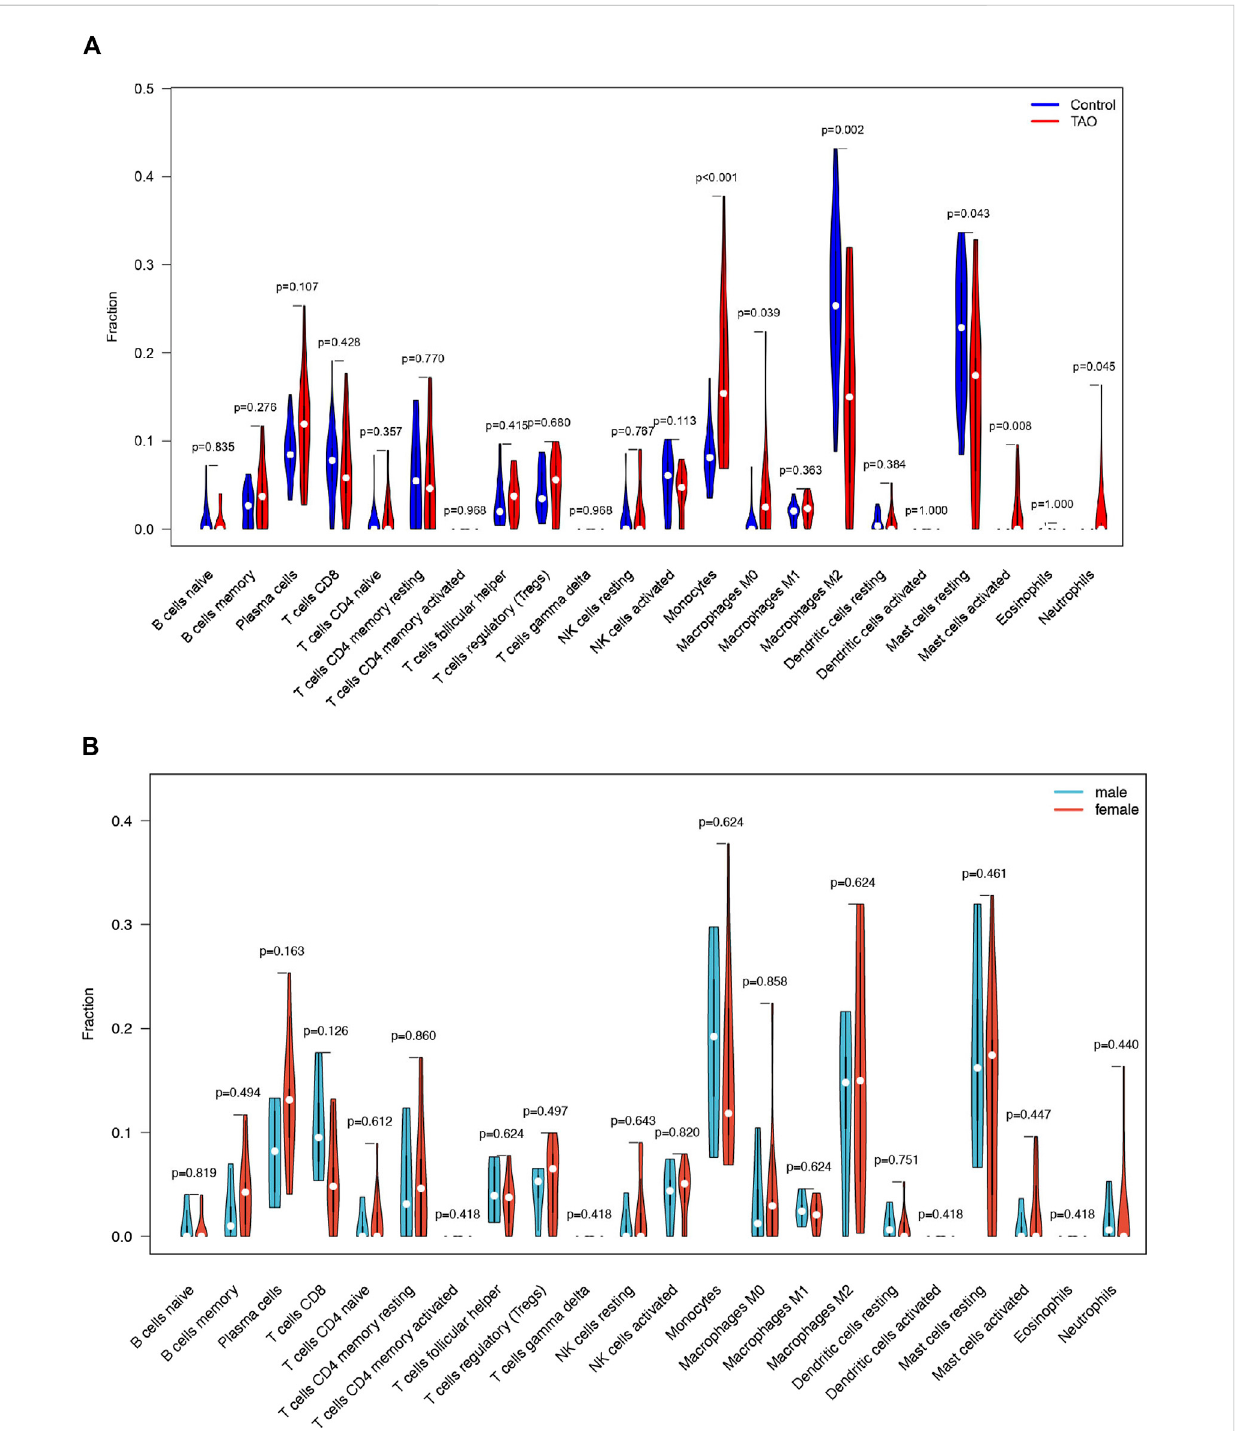
FIGURE 4 Thevioplotof22immunecellsin fi ltration.TheXcoordinateisthenamefor22immunecellsandtheYcoordinateisthefraction. (A) TheOrangeand blue violin represent expression of immune cells in TAO groups and control groups, respectively. (B) The Orange and blue violin represent expression of immune cells in female and male patients with TAO, respectively.